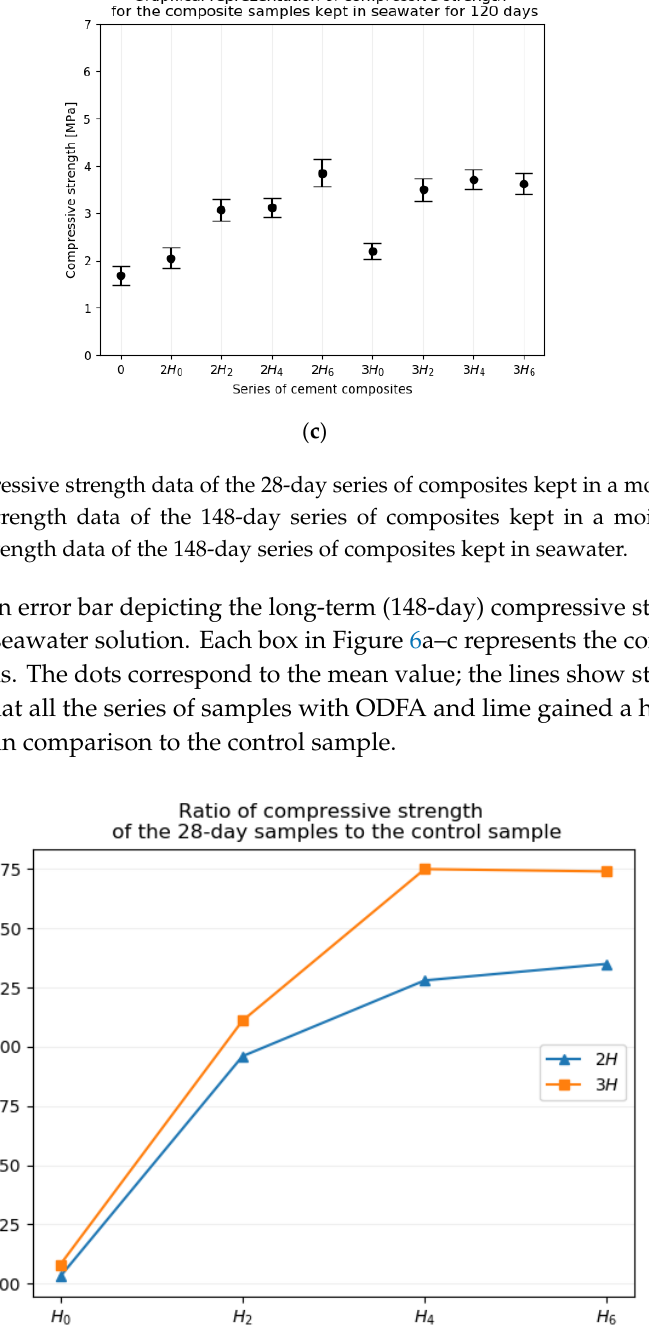
Figure 7. The changes in the compressive strength of the 28-day samples in comparison to the compressive strength of the control sample (the samples kept in a moisture chamber). The maximum increase of compressive strength was observed in the “3H4” and “3H6” series of samples, which amounted to 270.2% and 274.1%, respectively.